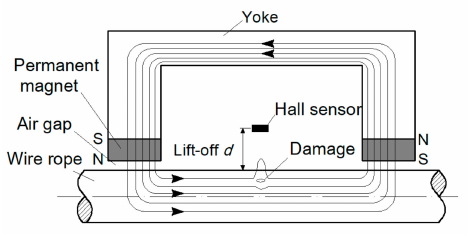
Figure 1. Schematic of the MFL